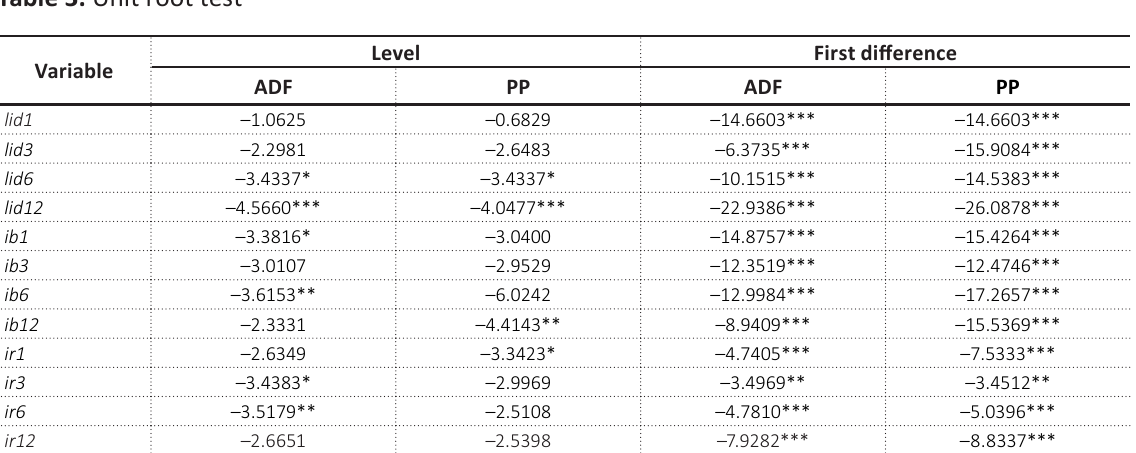
Table 3. Unit root